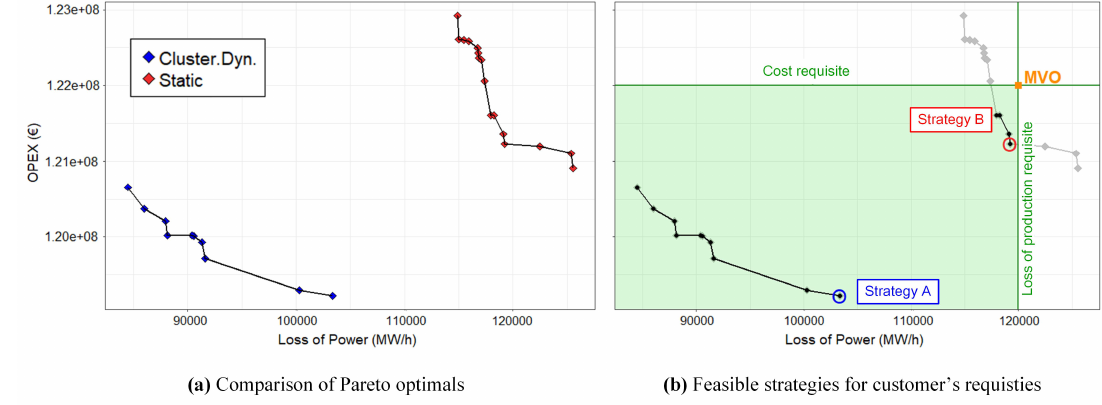
Figure 5. Pareto Front and Pareto Front with customer